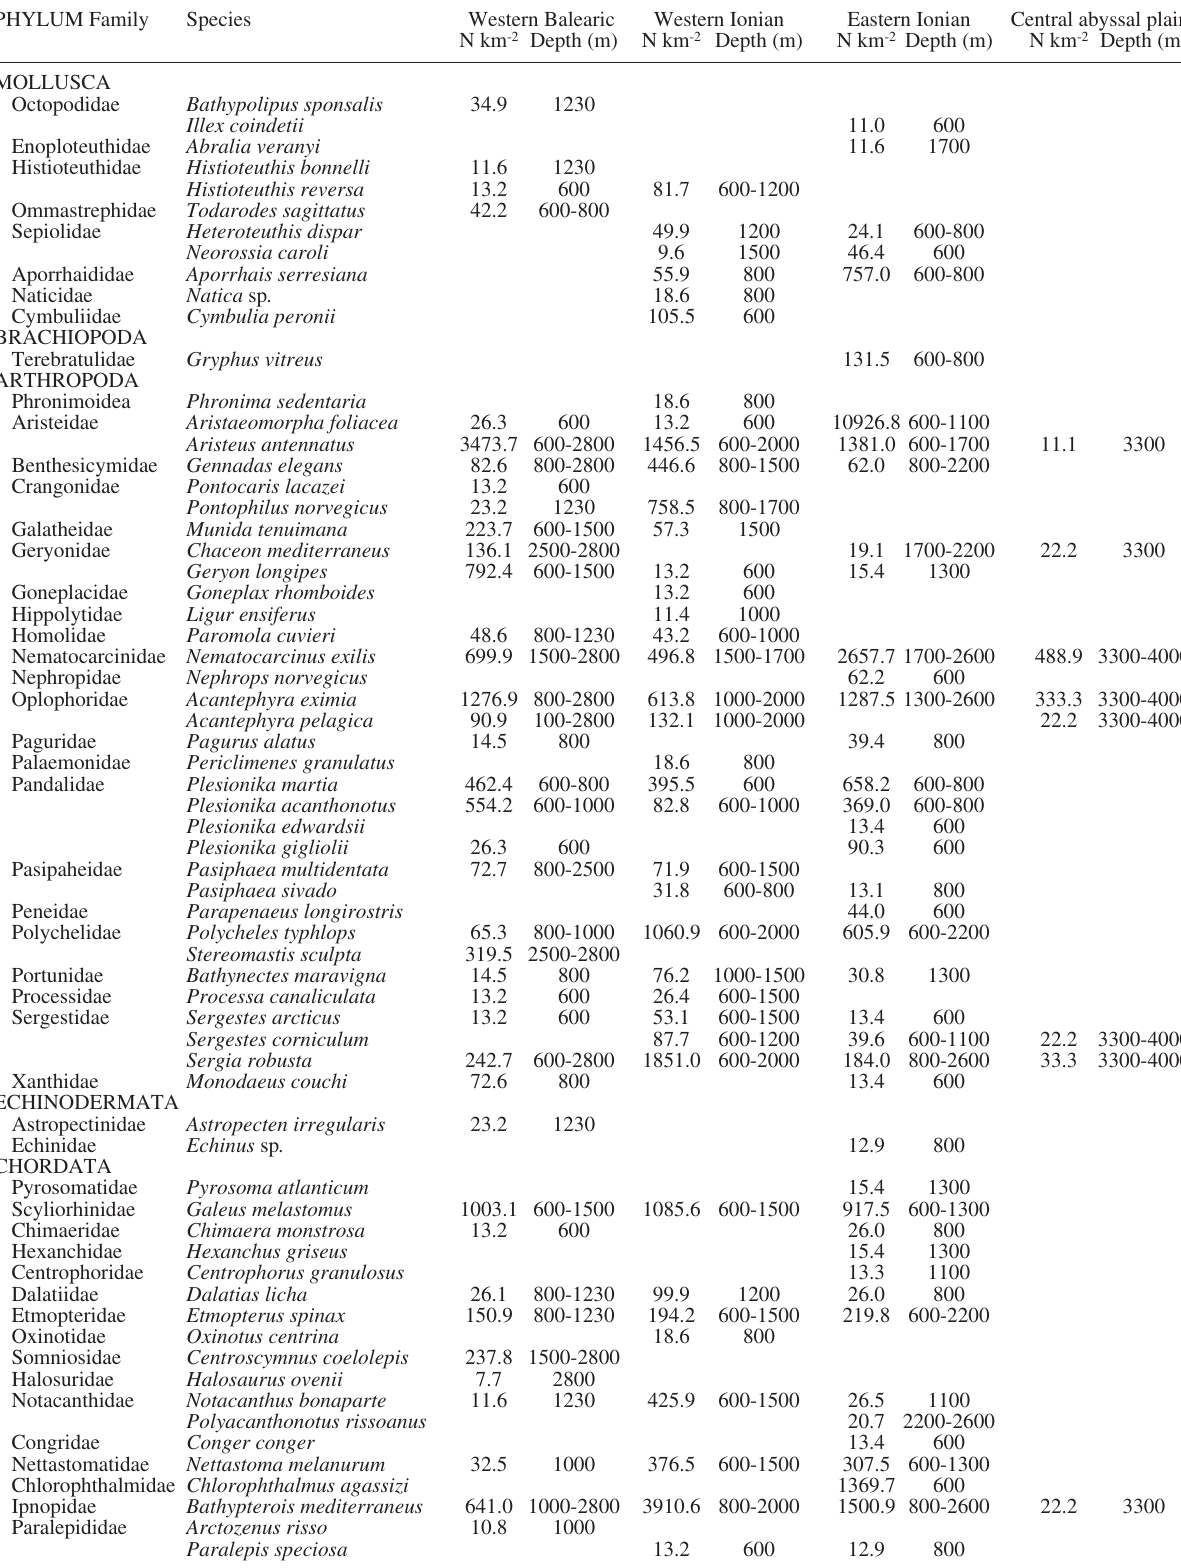
Table 2. – Species list of demersal megafauna sampled in the DESEAS cruise, along with their total collected abundance in each of the four samples areas, and their depth range of catch. PHYLUM Family MOLLUSCA